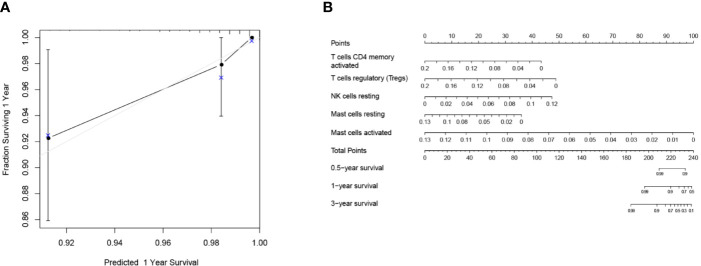
Validation and application of the Cox regression model. (A) Calibration curve of the Cox regression model; (B) The nomogram for predicting 3-year survival rates of EEA.